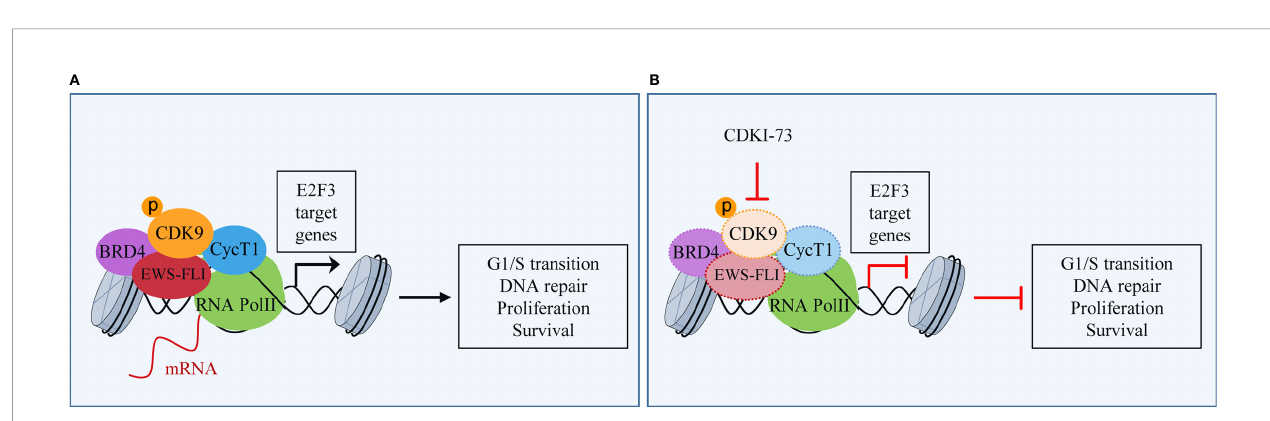
FIGURE 3 | CDK9 inhibitors used in soft tissue sarcomas.